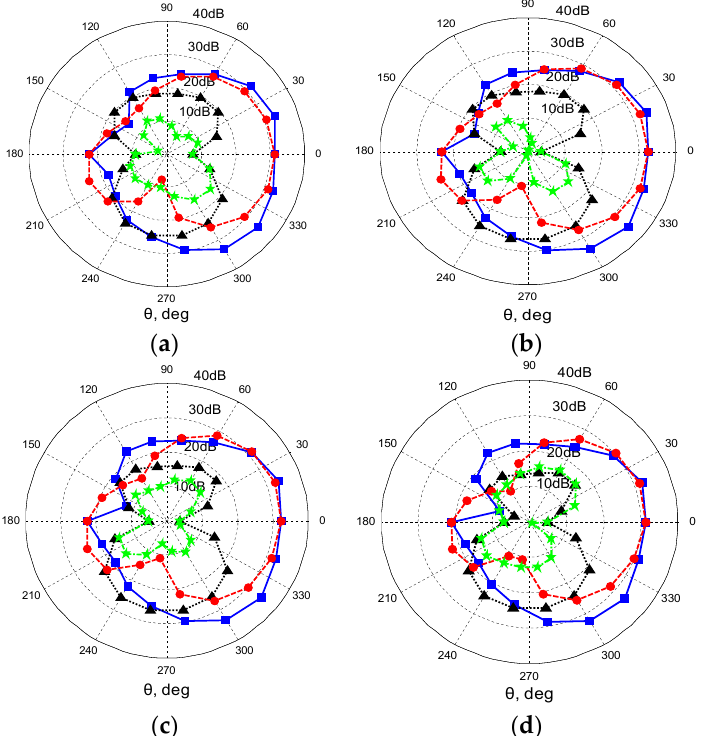
Figure 21. Simulated S parameters and HPBW of the anchor antennas as a function of frequency.